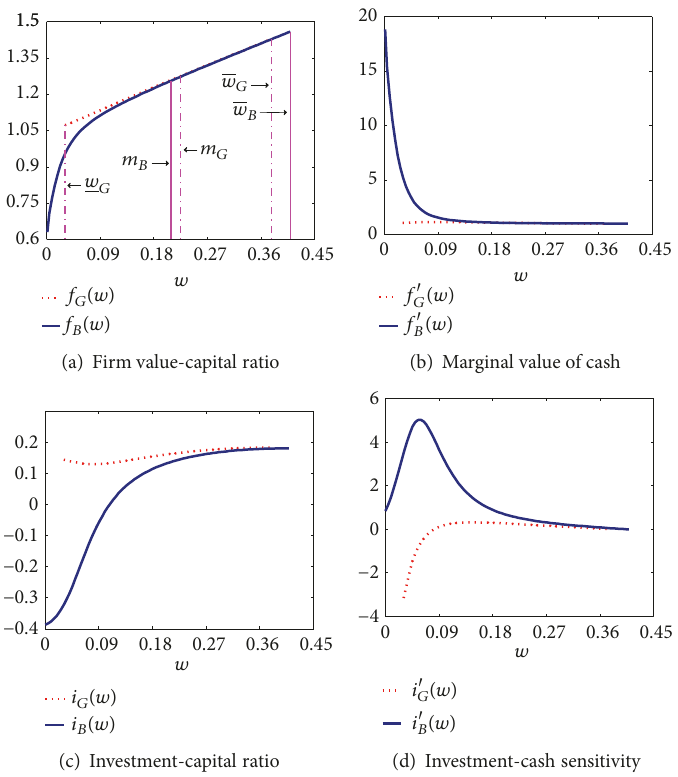
Figure 1: Comparing state 𝐺 with state 𝐵 : firm value-capital ratio and investment-capital ratio as well as their sensitivities.